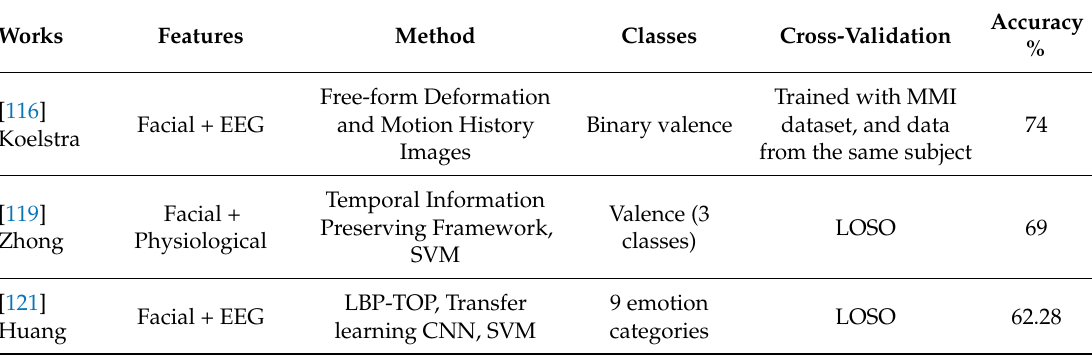
Table 3. Comparison with related works on valence classification using Mahnob-HCI